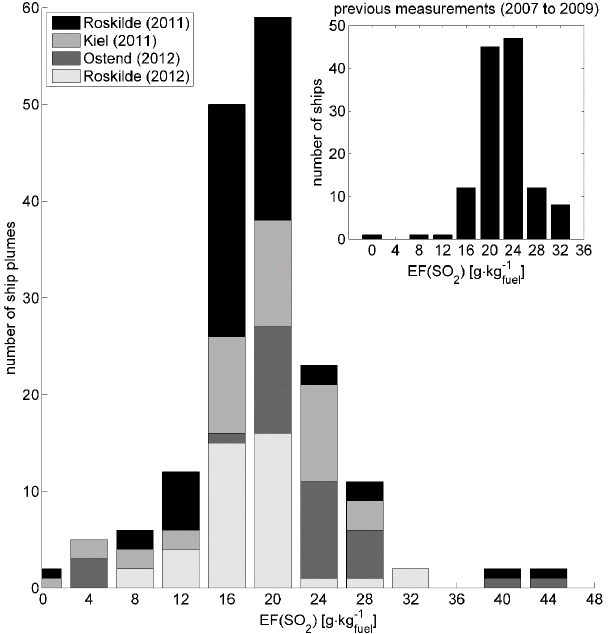
Figure 6. Histogram of the NO x emission factor, EF(NO x ) , relative to the amount of consumed fuel from airborne measurements for Figure 6: Histogram of the NO x emission factor, EF(NO x ), relative to the amount of consumed fuel from 2 three campaigns in the years 2011 and airborne measurements for three campaigns in the years 2011 and 2012. 3 4